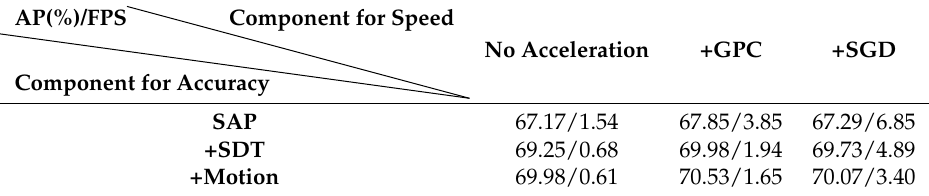
Table 2. AP and FPS on KITTI validation set under different setups of our